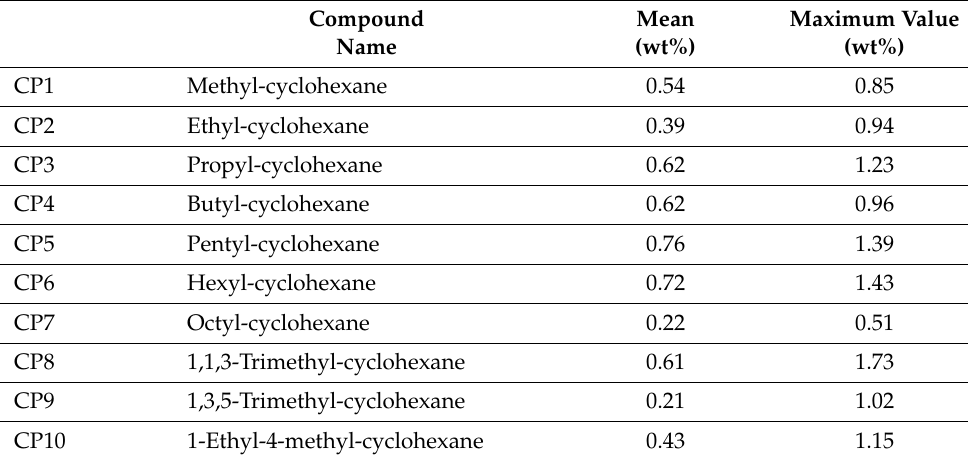
Table 4. Main individual components. Naphthenic family.